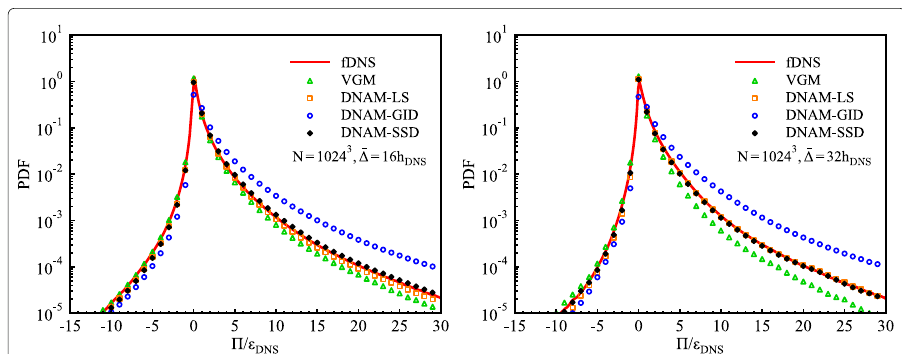
Fig. 4 PDFs of normalized SGS energy flux DNS in the apriori